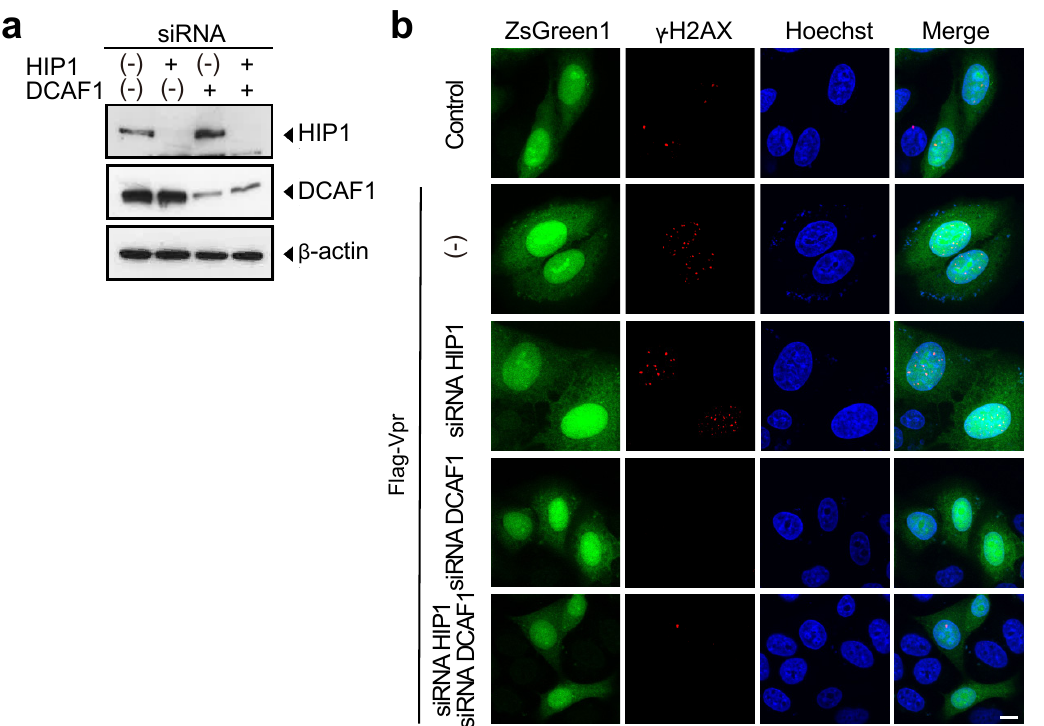
Figure 4. Vpr induces DNA double-strand breaks in HIP1 -knockdown cells. ( a ) HeLa cells were transfected with 5 nM HIP1 (siRNA#2), DCAF1 , or a combination of 5 nM HIP1 (siRNA#2) and 5 nM DCAF1 siRNAs. The total amount of siRNA was adjusted to 10 nM with control siRNA. At 48-h post-transfection, cells were lysed and subjected to SDS-PAGE and Western blot using the anti-HIP1 mAb, anti-DCAF1 mAb, and anti- β -actin mAb. The positions of HIP1, DCAF1, and β -actin are indicated. ( b ) HeLa cells were co-transfected with pME/F-Vpr-IRES-ZsGreen1 or control pME/F-IRES-ZsGreen1 and 5 nM HIP1 (siRNA#2), DCAF1 , or a combination of 5 nM HIP1 (siRNA#2) and/or 5 nM DCAF1 siRNAs. The total amount of siRNA was adjusted to 10 nM with control siRNA. At 48-h post-transfection, cells were fixed, permeabilized, and stained with the anti- γ -H2AX mAb, followed by Alexa Fluor 594-conjugated secondary antibody and 5 μ g/mL Hoechst33342. Cells were analyzed by a confocal microscopy. Cells showing green fluorescence (ZsGreen1+) and red foci indicated the presence of DNA double-strand breaks, and blue fluorescence indicated nuclei. The scale bar represents 10 μ m.